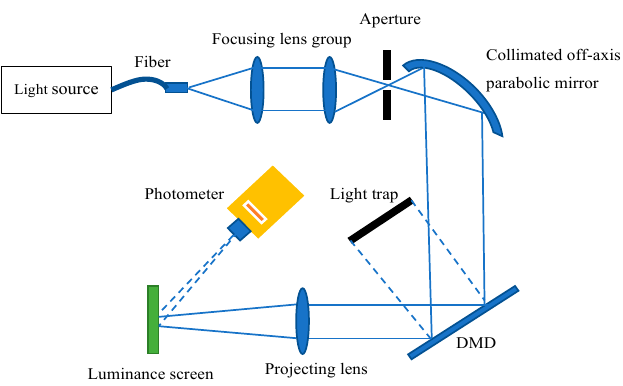
Figure 3. Schematic diagram of DGGE.